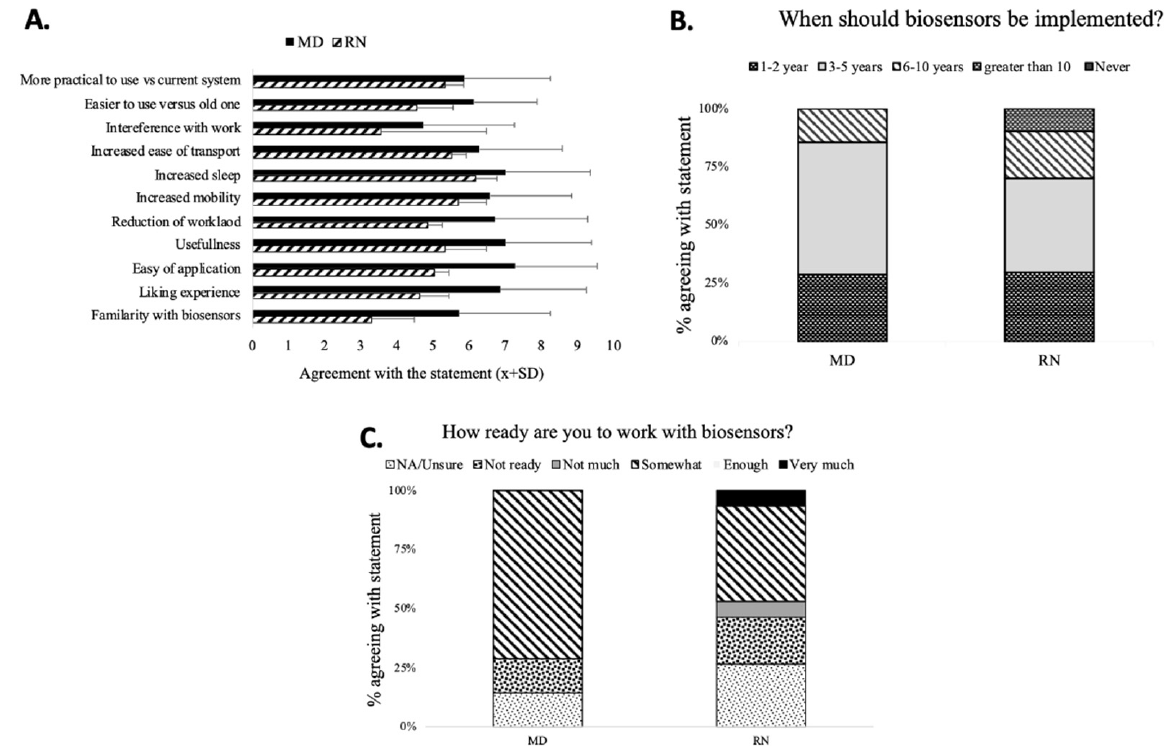
Figure 3. Readiness for implementation of biosensors. Physicians assessed the benefits of sensor deployment highly ( A ) and predicted faster implementation ( B ) than nurses. Nurses reported a more slightly unprepared perception of readiness to work with biosensors ( C ).